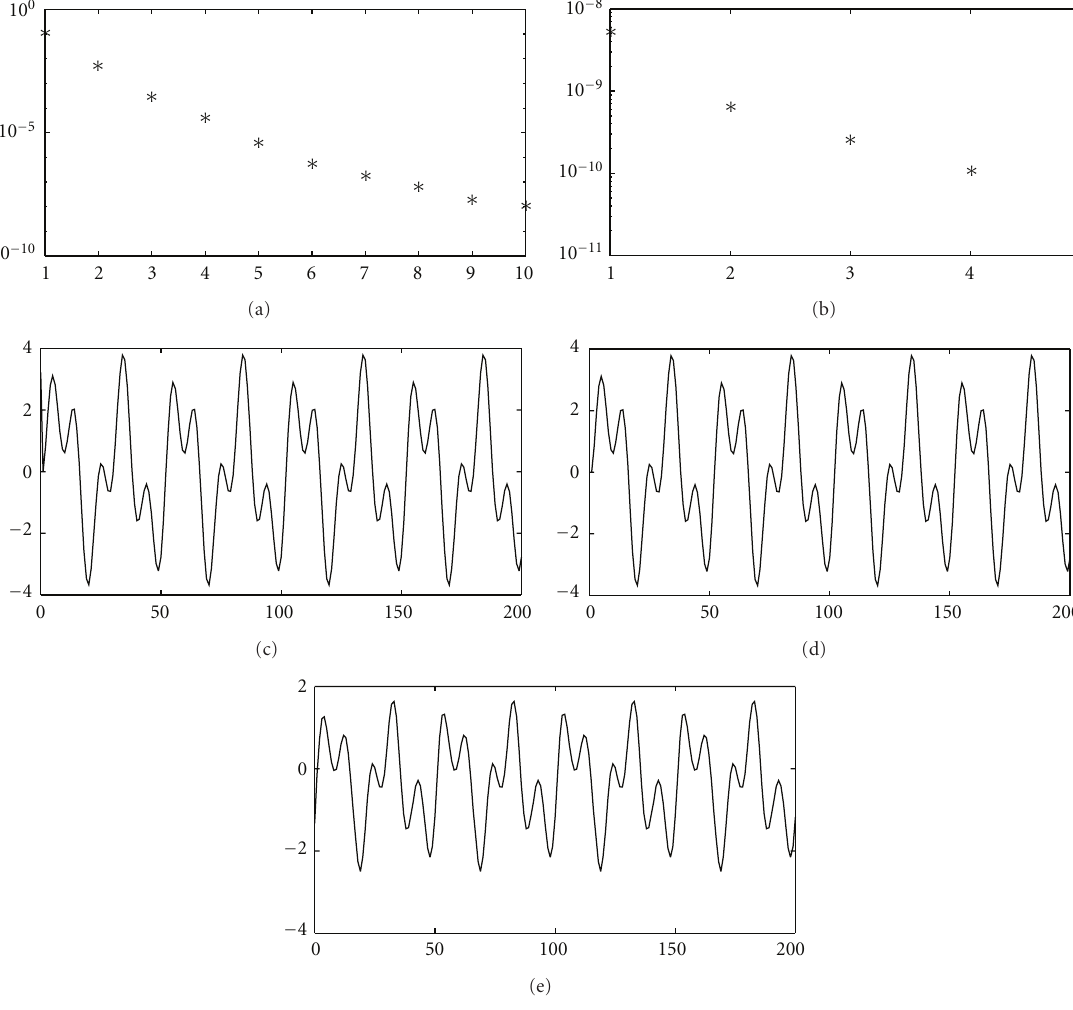
k t ) | versus identification process k at the 10th control I (